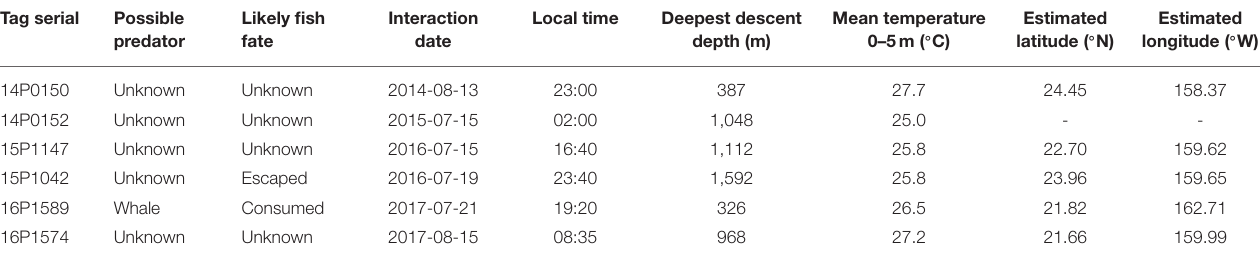
TABLE 2 | Possible yellowfin tuna interactions with predators.